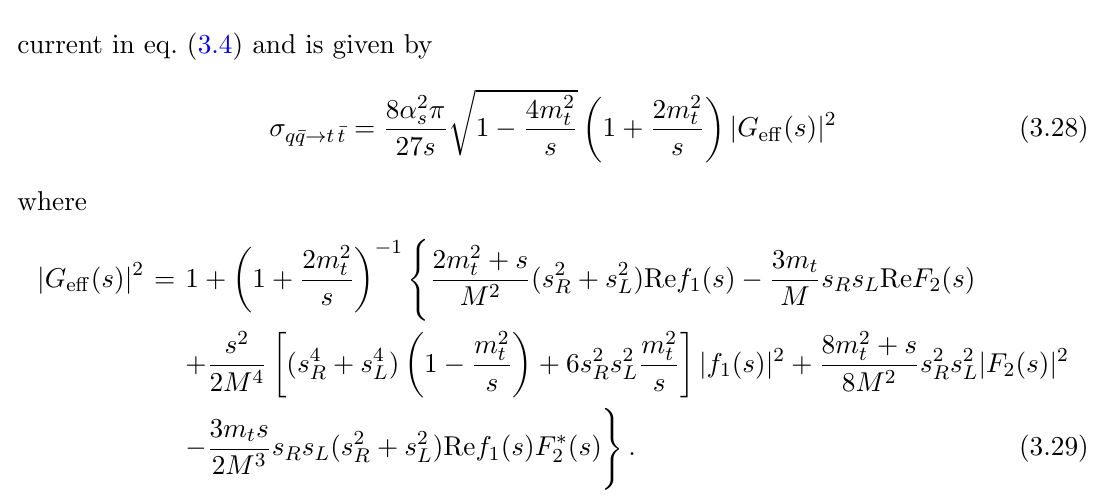
Figure 2 . Energy dependence of j G e(cid:11) ; T j 2 computed for pair production of fully composite (left plot) and partially composite (right plot) heavy top states. In this case we (cid:12)x f = 0 : 6 TeV, M = 9 f , M D = 5 f , (cid:20) g = 2 and (cid:17) = (cid:25)= 6. The arrows from left to right correspond to (cid:3) c , M (cid:26) = 6 f and 2 m T